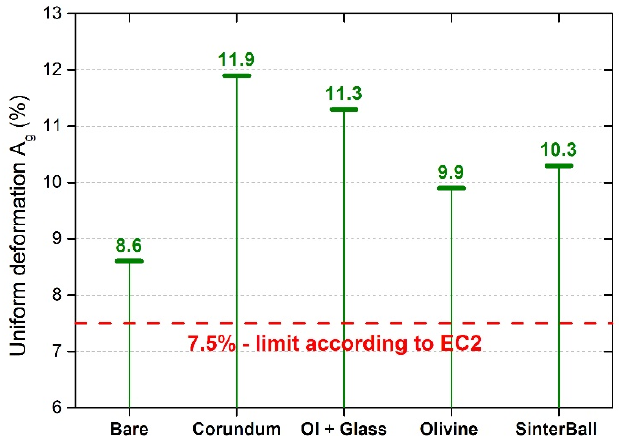
Figure 1. Plastic deformation A g to maximum force, in shot blasted specimens, in non-corroded conditions for different abrasive material in dual-phase steel.